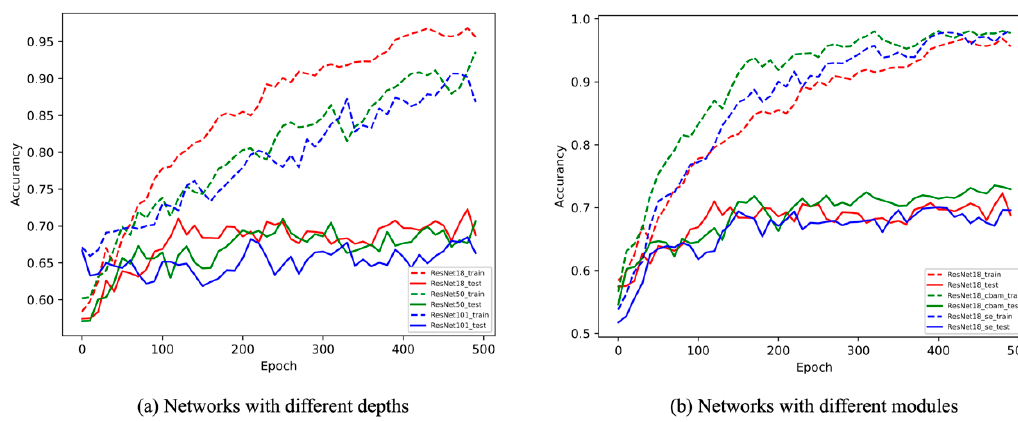
Figure 3. Training and testing accuracies of networks. The curves were obtained by averaging the accuracies of three times of five-fold cross validations. ( a ) Networks with different depths. ( b ) Networks with different modules.